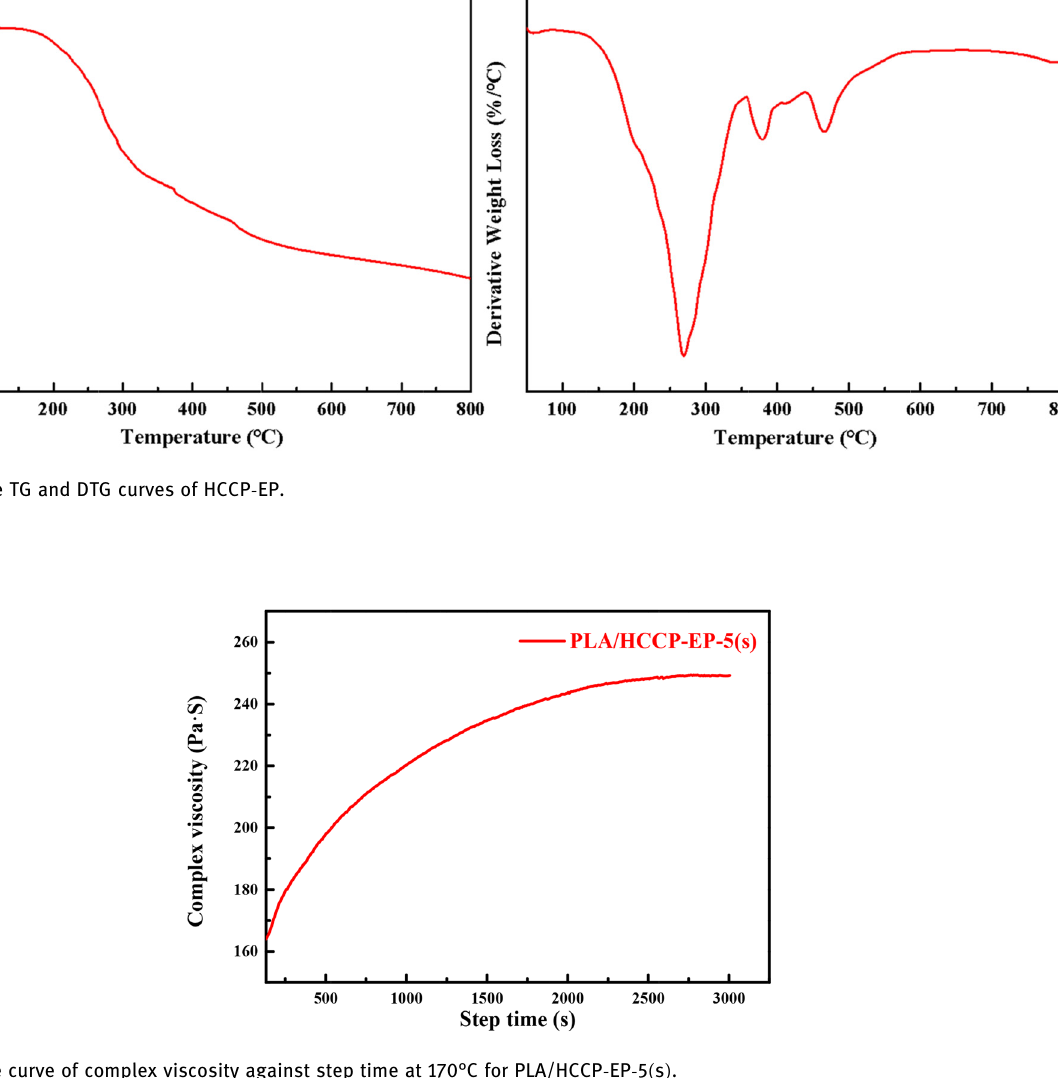
Figure A5: The curve of complex viscosity against step time at 170°C for PLA/HCCP - EP - 5 ( s )